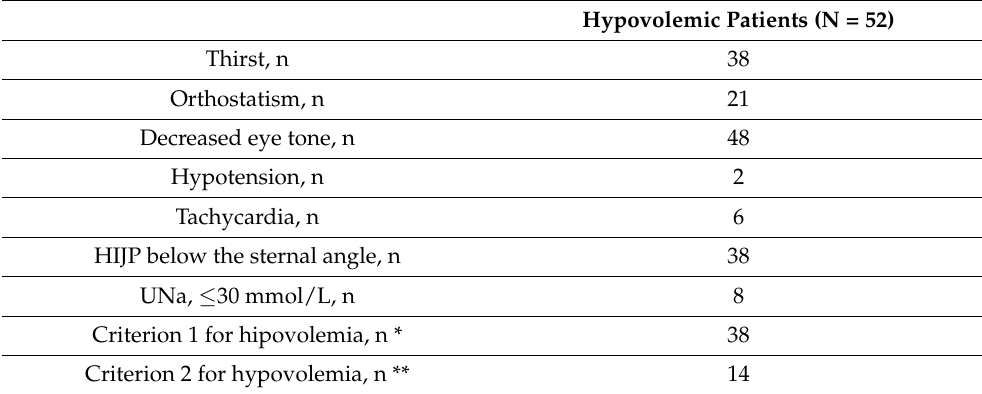
Table 1. Clinical parameters used to define